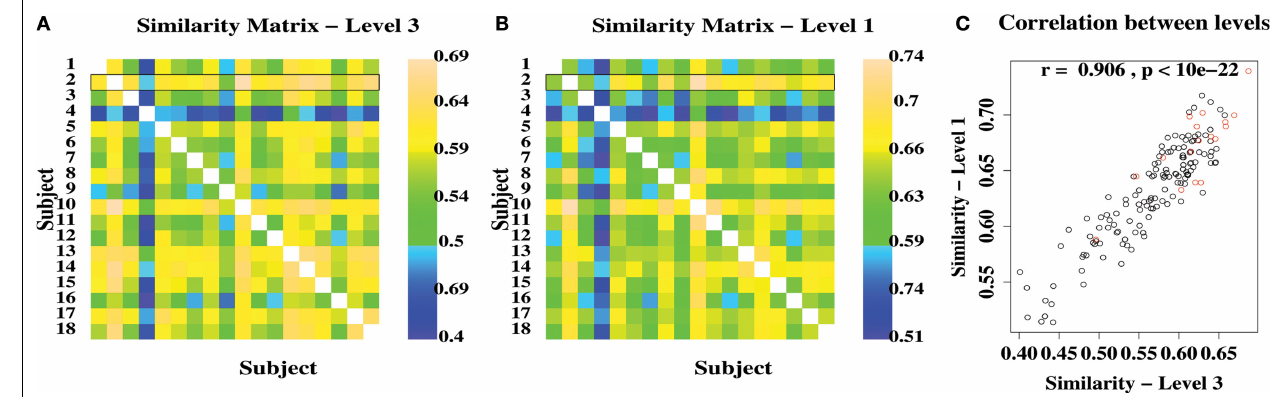
FIGURE 2 | Variability and similarity of brain functional network community structure between 18 different subjects. (A) Matrix showing the between-subject similarity measure for community structure at the highest level of the modular hierarchy. The pairwise similarity scores for the most representative subject are highlighted by a black rectangle. (B) Matrix